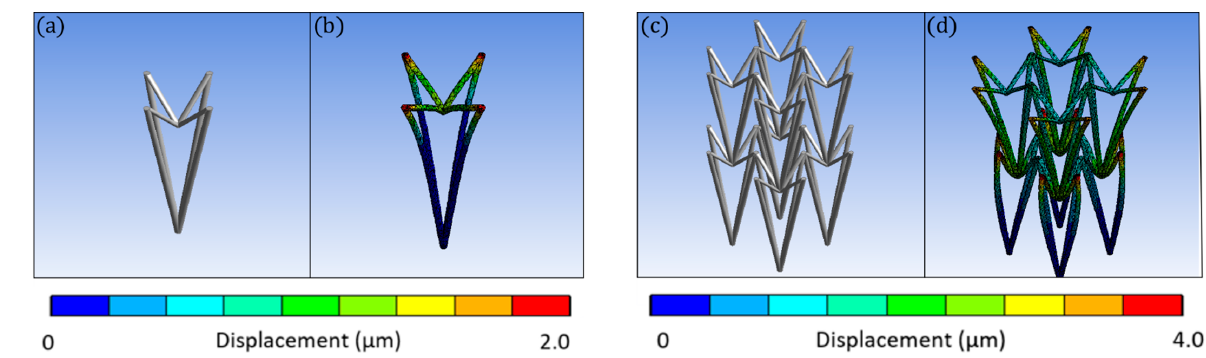
Figure 2. FEA simulations of the re-entrant triangular unit cell. ( a ) The undeformed unit cell, ( b ) A compression in the lateral direction causes compression of the beam members in the transverse direction, ( c ) An undeformed 2 × 2 × 2 undeformed lattice, and ( d ) Compression along the lateral direction causes a clearly more visible compression of the beam members in the transverse direction. Thus, the possession of auxetic behavior is scalable to an array of unit cells.